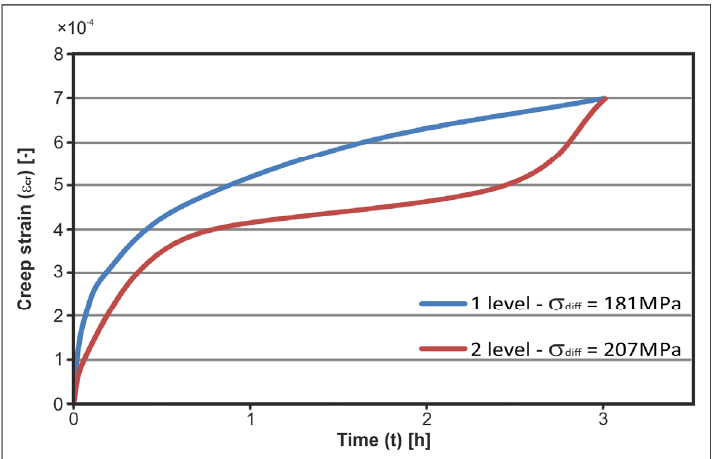
Figure 9. Comparison of axial creep strain for the first and second constant differential stress level in the brittle creep test for sample W-264-B.